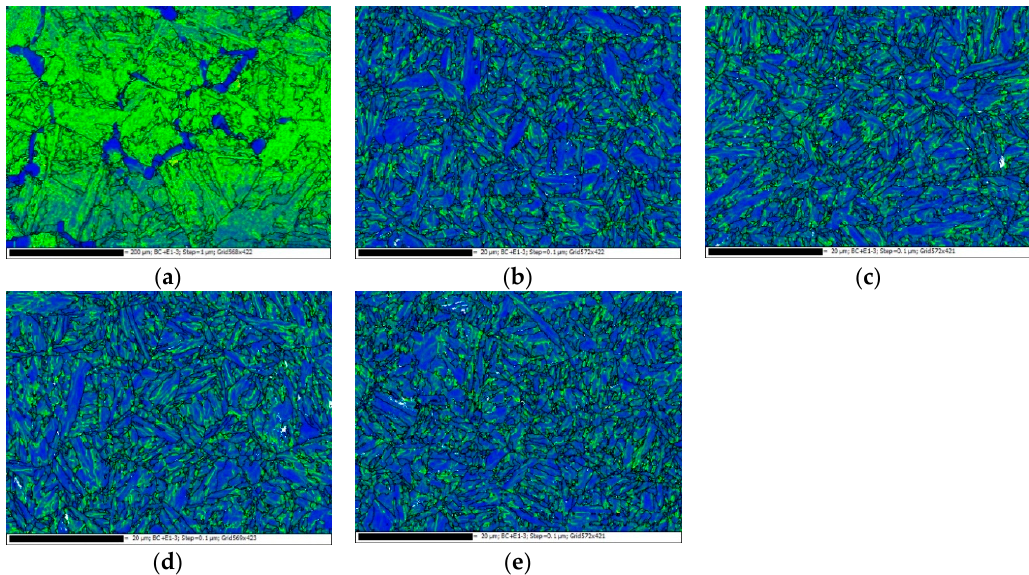
Figure 13. The local misorientation maps for ( a ) BM, ( b ) HD-L, ( c ) HD-T, ( d ) CF-L, and ( e ) CF-T.